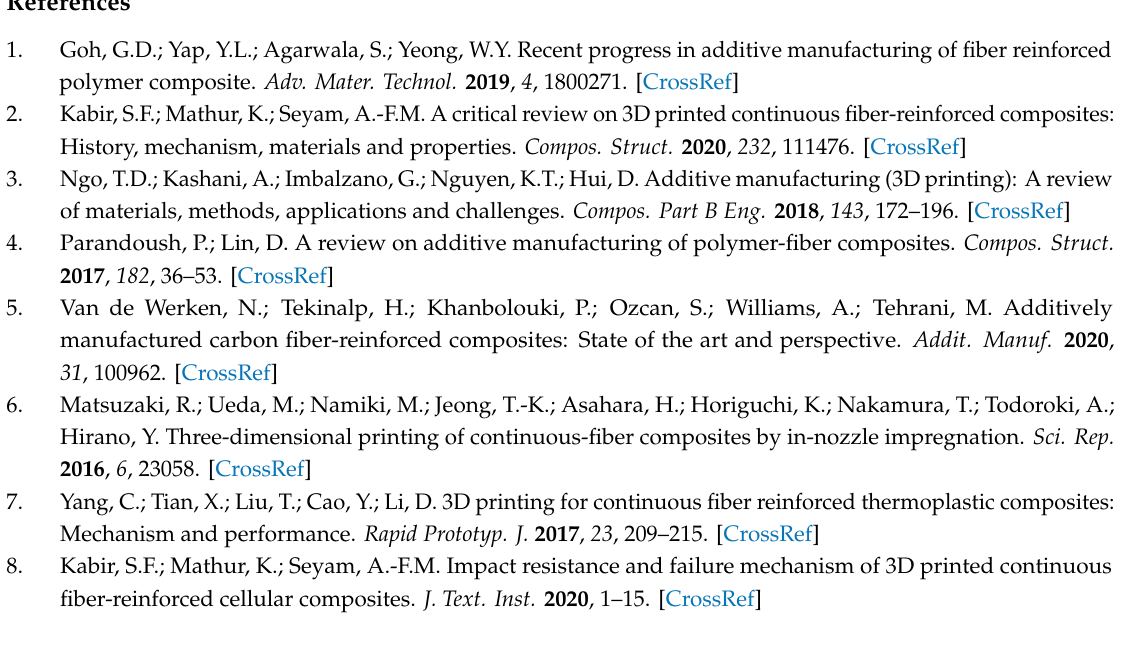
Figure S2: An example of uneven print bed. Although the bed level test at three corners shows good sign of leveling, the middle one su ff ers from low bed level that indicates imperfection in the flatness, Figure S3: The e ff ect of uneven bed (the images were taken after printing first layer, 0.1 mm thickness), printed good at some areas (a), with disjoint beads at some area (b) and with almost no materials at some area (c) (also a very good example of under extrusion due to printing with less material), Figure S4: First layer views at di ff erent layer heights indicating relative increment of coverage of gaps at the same bed level, Table S1: 2D layers view availed from the Eiger slicer, Table S2: Di ff erent views of the printed part using raise part option and regular part (without using ‘raise part’ option), Table S3: Plastic layer bead density for 30 mm × 30 mm sample with 1 wall layer, Table S4: Fiber layer bead density for 30 mm × 30 mm sample with 1 wall